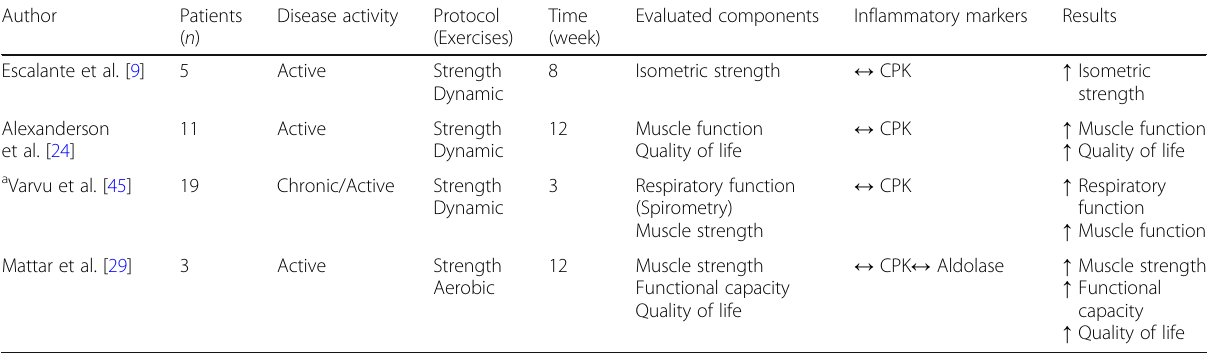
Table 3 Physical exercise among patients with dermatomyositis, newly diagnosed polymyositis, clinically active disease, or some combination therein